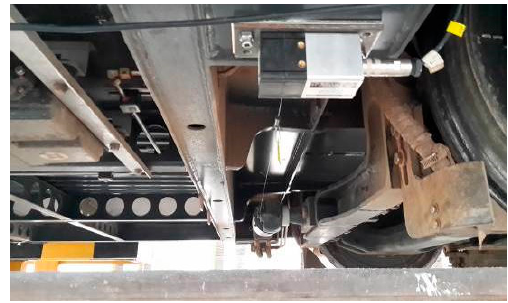
Figure 22. Schematic diagram of sensor installation position.